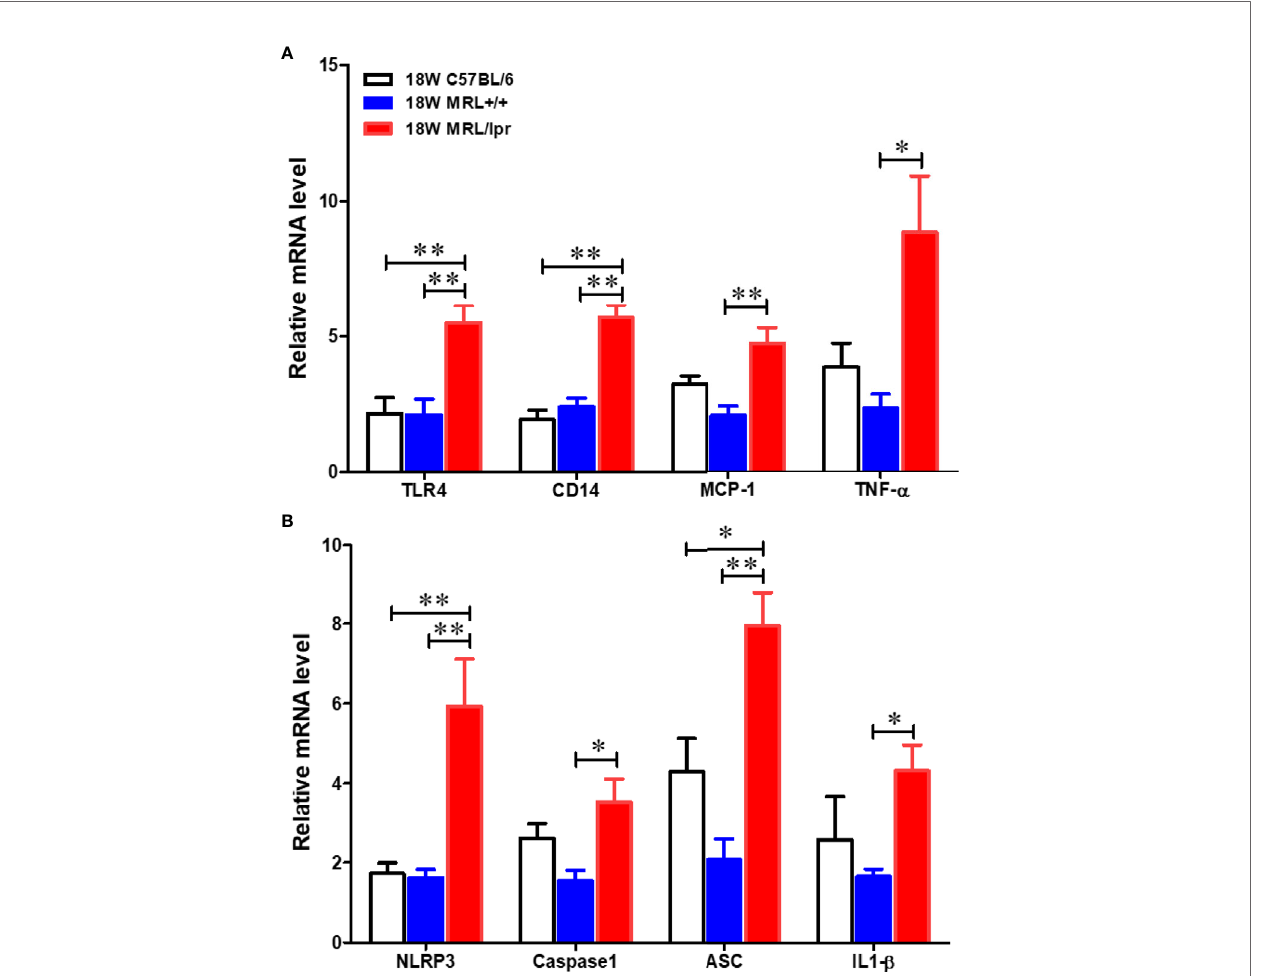
FIGURE 3 | Up-regulation of in fl ammatory genes in the livers of C57BL/6, MRL+/+ and MRL/lpr mice. Total RNA was extracted from liver tissues and relative mRNA expressions of (A) in fl ammatory markers [Toll like receptor 4 (TLR4), CD14, MCP-1 and TNF- a ] and (B) in fl ammasome activation markers (NLRP3, caspase-1, ASC and IL-1 b ) were determined by RT-PCR. Results are Mean ± SEM. n = 5 * p < 0.05; ** p <